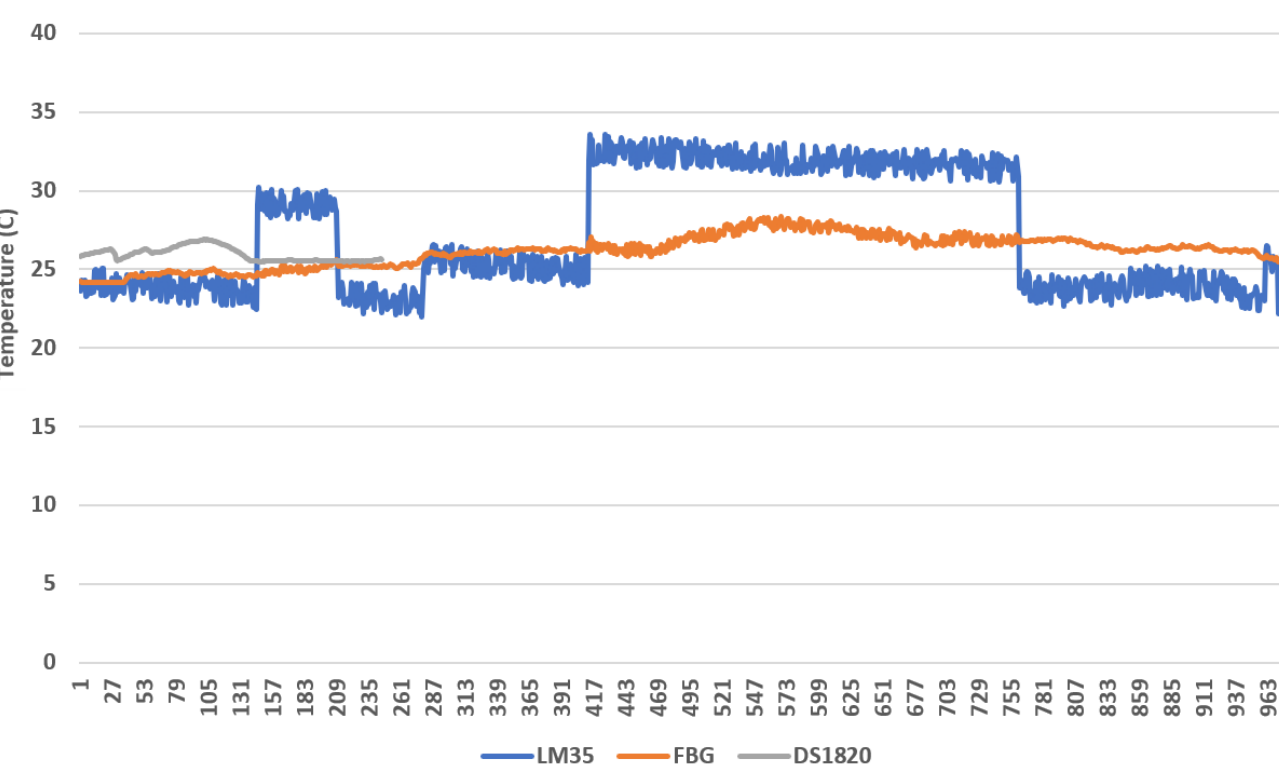
Figure 11. HV effects on the FBG, LM35, and DS18B20 sensors.